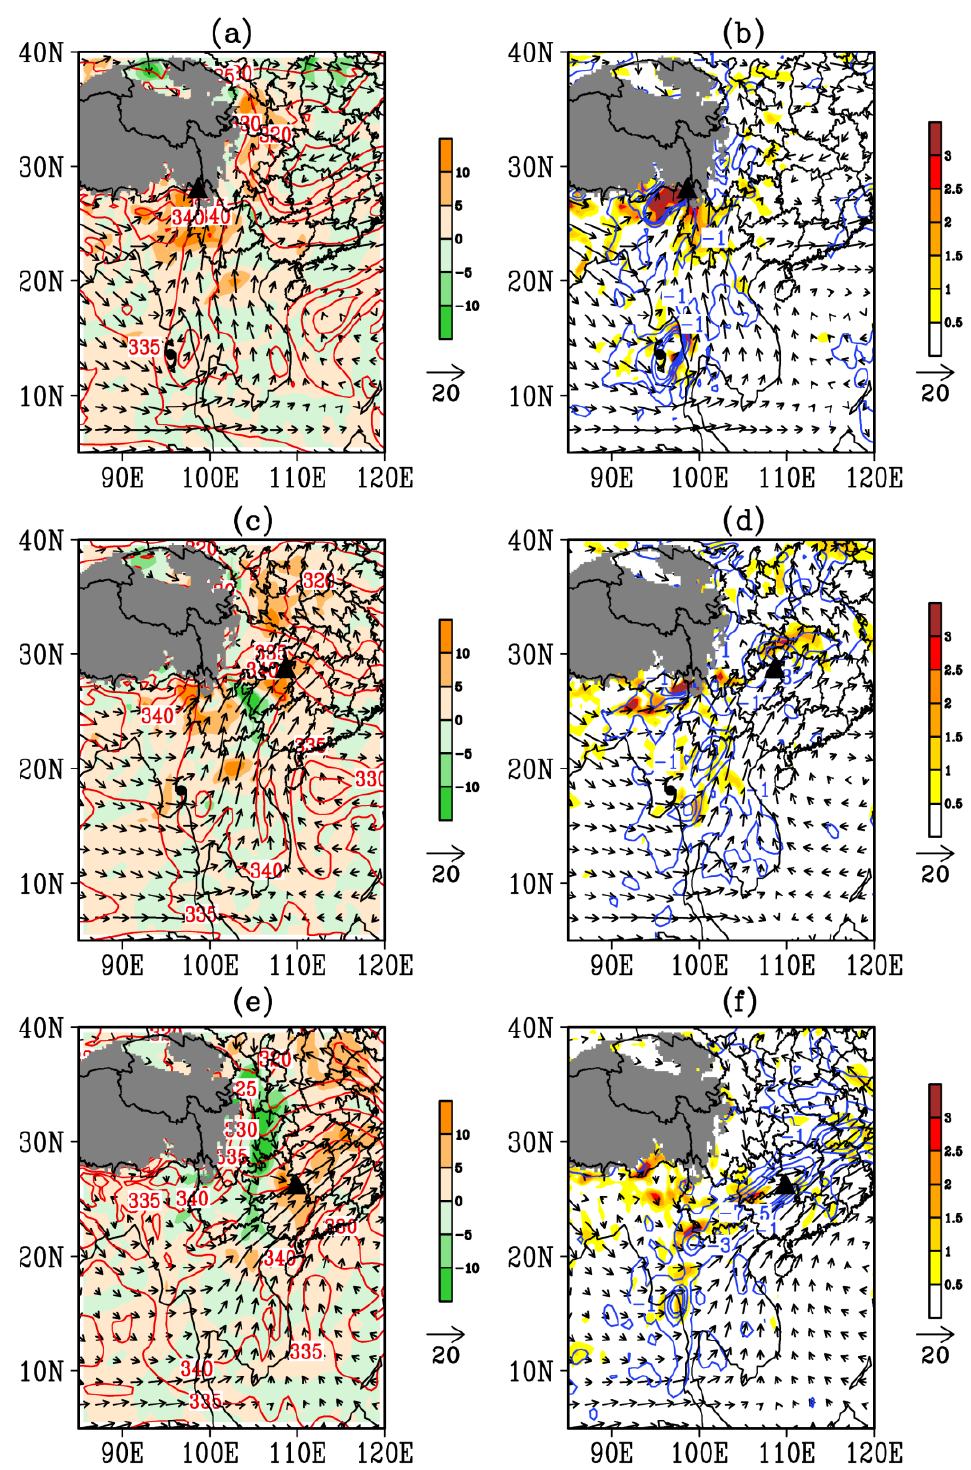
Figure 10. Horizontal wind (vector, units: m s − 1 ), horizontal temperature advection (shaded, units: 10 − 5 K s − 1 ), and equivalent potential temperature (red contour, units: K) at 700 hPa for ( a ) 11 May 2002, ( c ) 12 May 2002, ( e ) 13 May 2002. And frontogenesis (shaded, units: 10 − 9 K m − 1 s − 1 ) at 700 hPa and vertical pressure velocity (the values less than 0 are indicated in blue contours, units: 10 − 2 pa s − 1 ) at 500 hPa for ( b ) 11 May 2002, ( d ) 12 May 2002, ( f ) 13 May 2002. The locations of the tropical cyclones are indicated by black tropical storm symbols. The centers of maximum precipitation are indicated by triangle symbols.